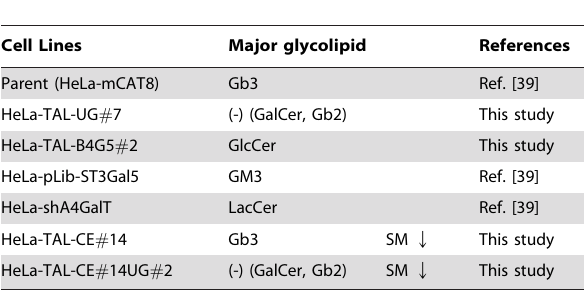
Table 1. A panel of sphingolipid-modified HeLa cell Figure S1 Amino acid sequences of original and mod- ified TALENs. Underlines in the N-terminal TALE (TALE-N) indicate a nuclear localization signal, and a box indicates an HA tag. Two asterisks in the repeat region indicate the repeat variable di-residue (RVD), which decides the nucleotide-binding specificity of each TALE repeat region. Arrows in FokI cleavage domain ( sharkey ) indicate the mutated amino acids. Figure S2 Repeat variable di-residue sequences in the TALENs used in this study. Figure S3 Characterization of the large deletion allele of CERT gene in TAL-CE # 14 clone. A, Schematic diagrams indicate the disruption of CERT gene in the genome and the resultant exon 2-skipped mRNA in TAL-CE # 14 clone. The numbers on the diagrams indicate the sequence numbers from the A of the translation initiation codon, based on CERT mRNA